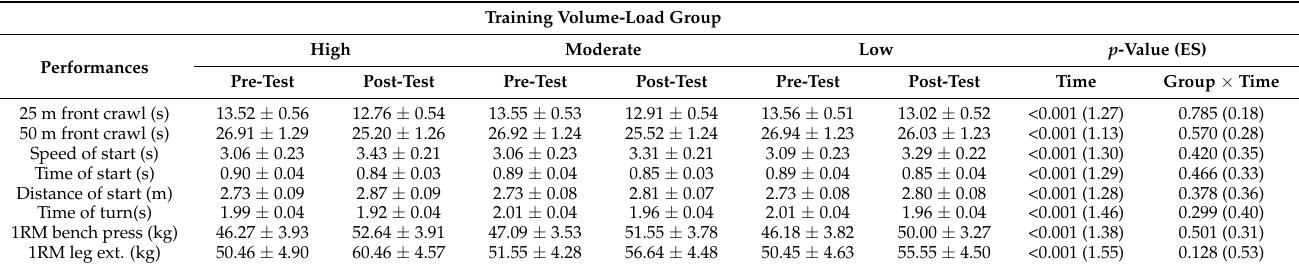
Table 4. Group-specific pre-test and post-test performances after 9 weeks of an in-season maximal strength training on muscle strength and swimming-specific performance in competitive